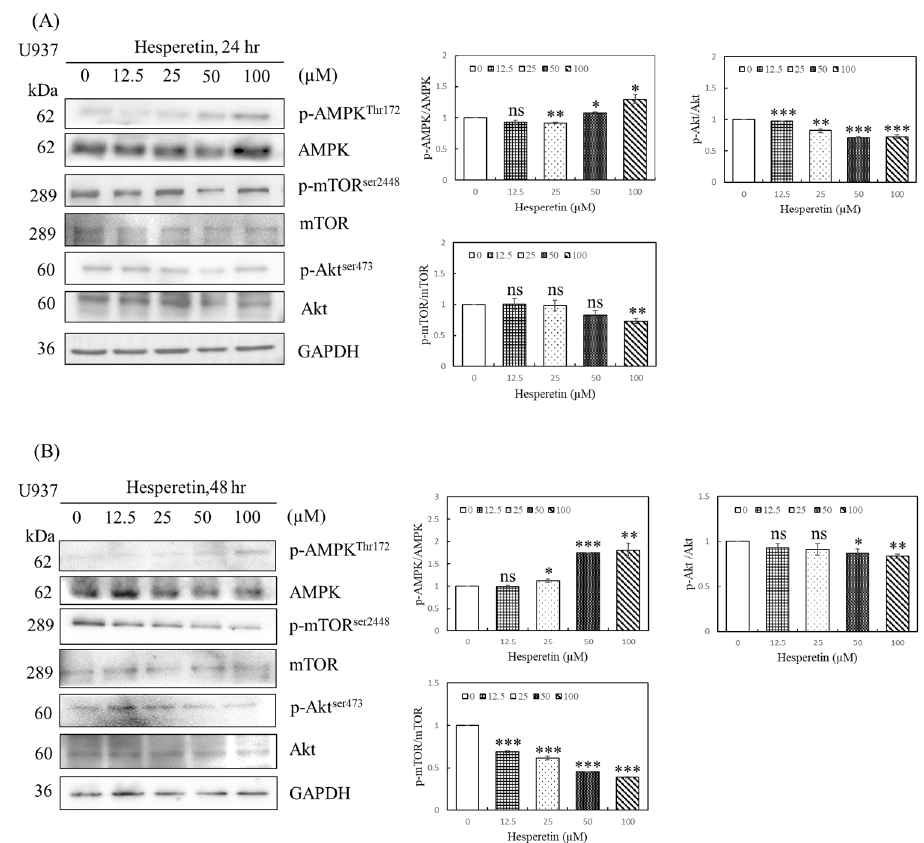
Figure 4. Effect of hesperetin on the AMPK/Akt/mTOR signaling pathway in U937 cells. U937 cells (5 × 10 5 ) were treated with hesperetin at 0, 12.5, 25, 50, and 100 µM for 24 h ( A ) and 48 h ( B ). The expression of phospho-AMPK Thr172 , AMPK, phospho-mTOR Ser2448 , mTOR, Phospho-Akt Ser473 , Akt and GAPDH was analyzed with Western blotting and semiquantified; representative results of the same pattern from three independent experiments are shown. The mean ± SD of the three independent experiments performed in triplicate are shown. * p < 0.05; ** p < 0.01; *** p < 0.001 vs. the control group; ns, not significant; the results are representative of three independent